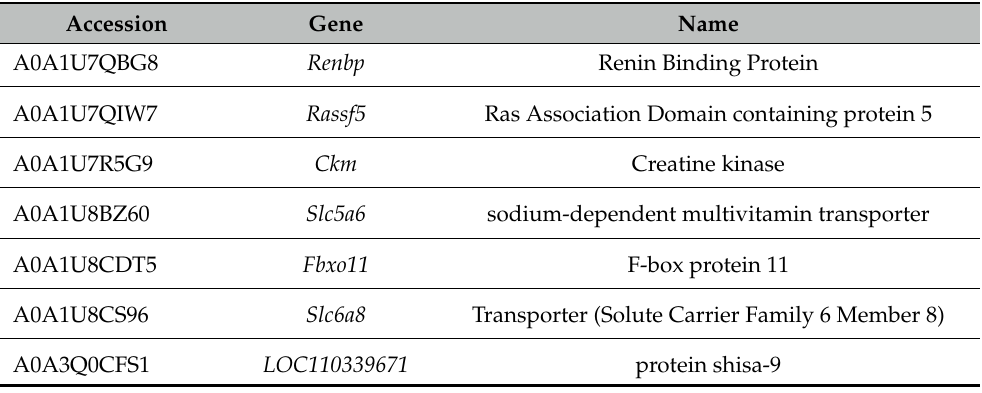
Table 2. Proteins exclusive to the IC of control hamsters .